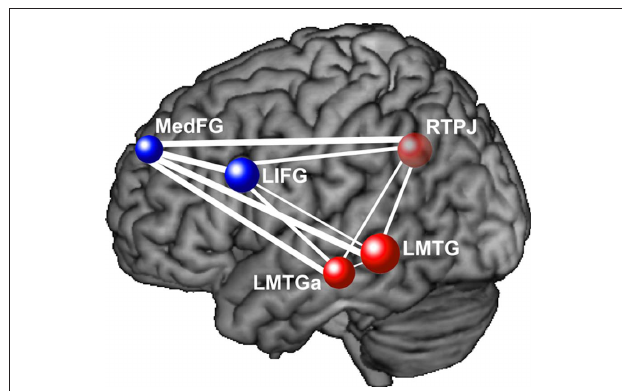
FIguRe 1 | This diagram depicts functional underconnectivity, specifically between frontal and posterior areas, in autism during an inferential text comprehension task. The width of each connecting line represents the t -value of the difference in functional connectivity between the participants with autism and the neurotypical participants. Blue nodes are frontal regions and red nodes are posterior regions. The widest lines (reflecting the greatest group differences) are those connecting frontal and posterior regions. Data from Mason et al. (2008), with permission. MedFG, medial frontal gyrus; LIFG, left inferior frontal gyrus; RTPJ, right temporo- parietal junction; LMTG, left middle temporal gyrus; LMTGa, anterior left middle temporal